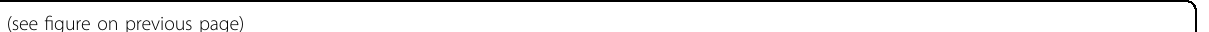
Fig. 5 In fl ammatory changes in the skin and small intestine elicited by EC challenge were attenuated in eosinophil-de fi cient Δ dblGATA mice. A Hematoxylin and eosin staining of skin from the control Δ dblGATA (GATA-Con), EC-challenged Δ dblGATA (GATA-EC), and orally tolerized and EC-challenged Δ dblGATA (GATA-OT-EC) mice. The images are representative of two independent experiments. The scale bar represents 200 μ m. B The thickness of the whole skin (left), epidermis (middle), and dermis (right) of the indicated mice. The graphs show the mean ± SD values. * P < 0.05, **** P < 0.0001 (one-way ANOVA). C mRNA expression of Il1b , Il1rl1 , Il17a , Il25 , Il33 , Il5 , Il13 , Flg , Lor , Mcpt1 , Ccr3 , Prg2 , and Ccl11 in the skin of the indicated mice. All data are representative of two independent experiments. The graphs show the mean ± SD values. * P < 0.05, ** P < 0.01 (Student ’ s t - test for Il1rl1 and Il33 ; Mann – Whitney tes t for Mcpt1 , Ccr3 , and Prg2 ). D mRNA expression of Il1b , Il6 , Tnf , Il17a , Il25 , Il33 , Il13 , Cldn4 , Mcpt1 , Ccr3 , Prg2 , Ccl11 , and Ccl5 in the small intestine of the indicated mice. All data are representative of two independent experiments. The graphs show the mean ± SD values. * P < 0.05, ** P < 0.01, *** P < 0.001 (Student ’ s t -test for Il1b , Il6 , Tnf , Il17a , and Cldn4 ; Mann – Whitney test for Ccr3 , Prg2 , and Ccl5